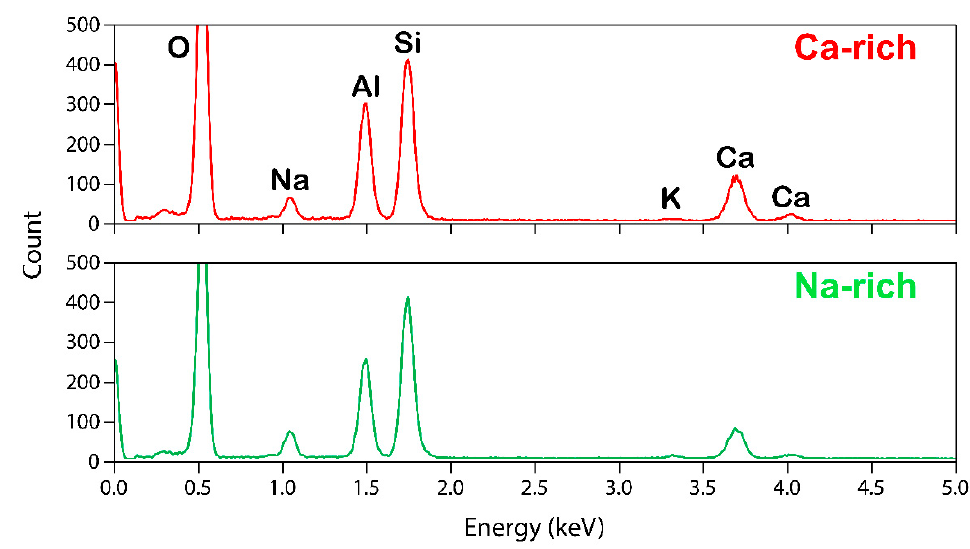
Figure 5. Representative EDS spectra of the Ca-rich and Na-rich lamellae extracted from the EDS maps in Figure 4. The spectrum from the Ca-rich lamella obviously has larger Ca/Na and Al/Si ratios than the Na-rich lamella does.